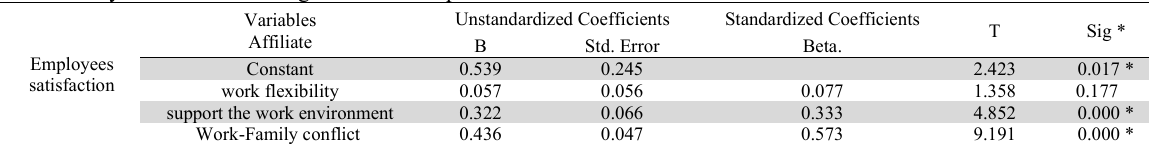
The summary of the results of regression technique Employees satisfaction